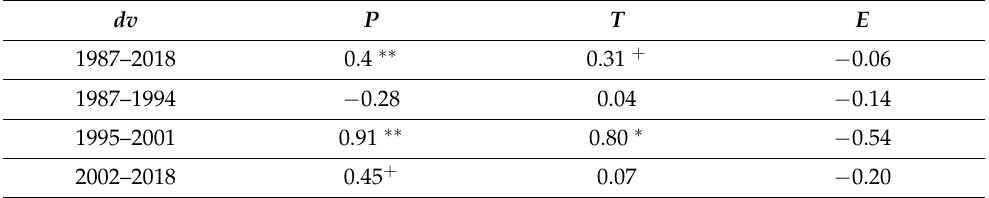
Table 2. The Pearson correlation coefficient between the storage change of Hala Lake and climate factors. dv P T